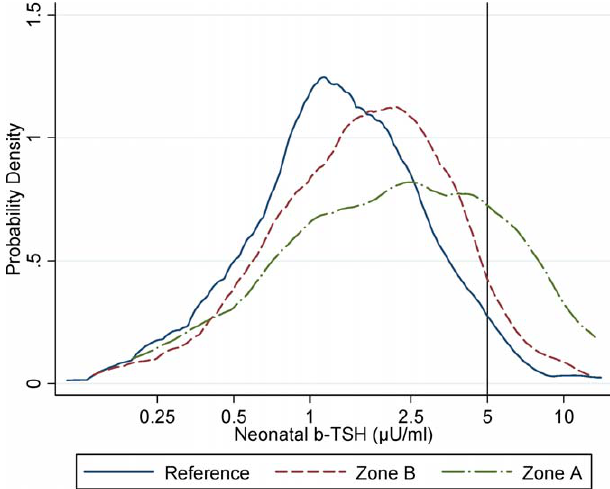
Figure 1. Distribution of Neonatal b-TSH by Dioxin Contamination Zone Neonatal b-TSH distribution for children born between 1994 and 2005 to women from zone A ( n ¼ 54), the zone most contaminated by TCDD after the Seveso accident; zone B ( n ¼ 425); and the surrounding non- contaminated reference area ( n ¼ 533). The graph shows kernel density estimates by zones. *According to the WHO [1], the percentage at the population level of newborns with a b-TSH value greater than 5 l U/ml should be less than 3% in iodine-replete areas.